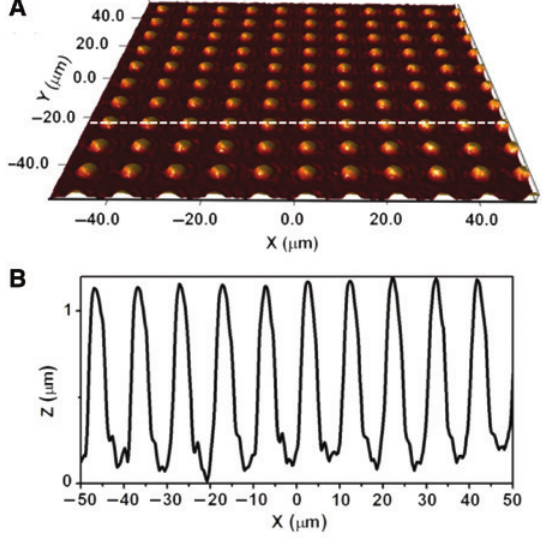
Figure 2: Microscopic characterization of the microlens array. (A) 3D topographic image and (B) cross-sectional profile of MLA.